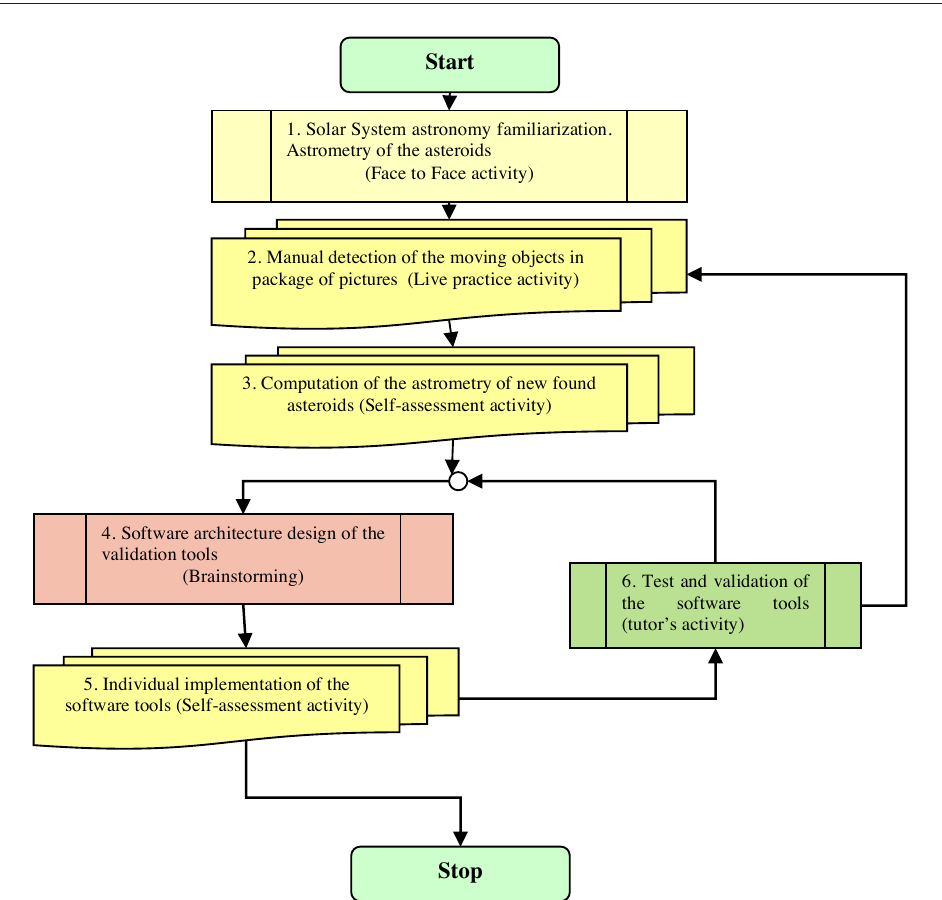
Fig. 1. The diagram of the computational astronomy learning modules